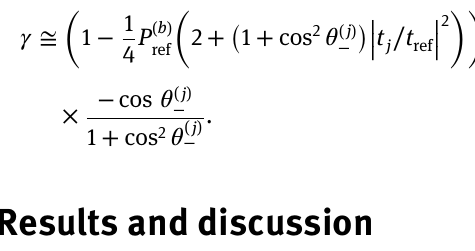
∕ T ) is maximized at 684 nm which is chosen as HH VV versus delay. The solid red curve is a ii ′